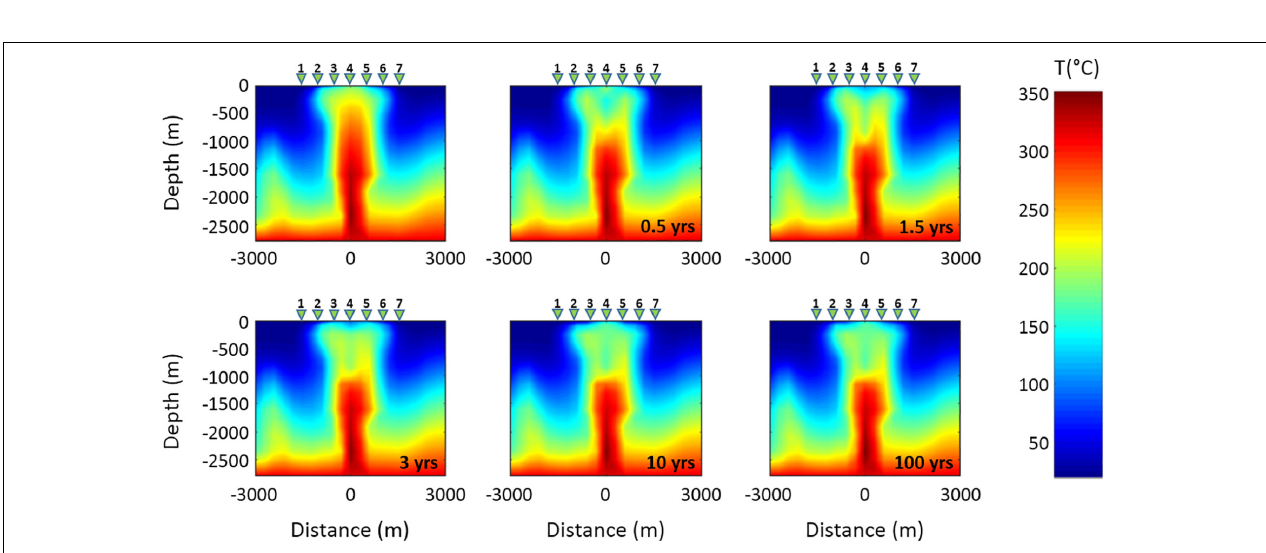
FIGURE 9 | Time evolution of the temperature distribution related to Scenario II in the vertical section along the red line shown in Figure 3 . The first panel of the sequence shows the initial temperature distribution. The green triangles 1–7 indicate the MT stations.